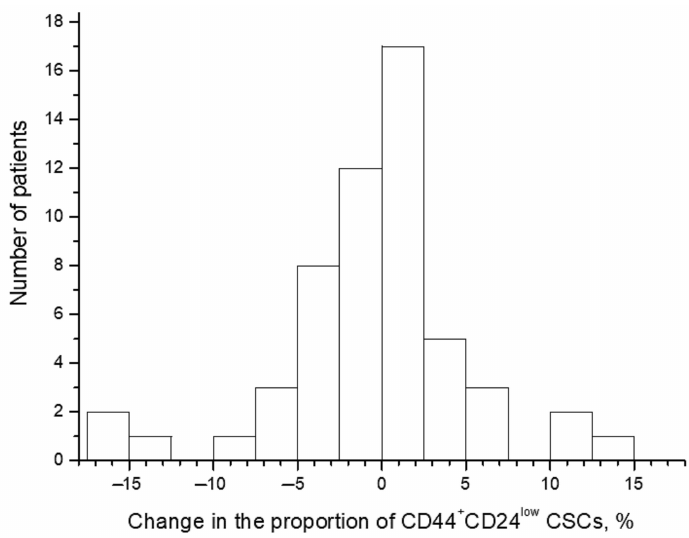
Figure 2. Distribution of patients with CC according to the changes in the proportion of CD44 + CD24 low cancer stem cells (CSCs) after radiation exposure at a total dose (TD) of 10 Gy. The changes were calculated for each patient by the following formula: (the proportion of the CSCs after radiation exposure) − (the pretreatment CSC proportion). Thus, positive values indicate an increase in the proportion of CSCs after irradiation, whereas negative values indicate a decrease in this